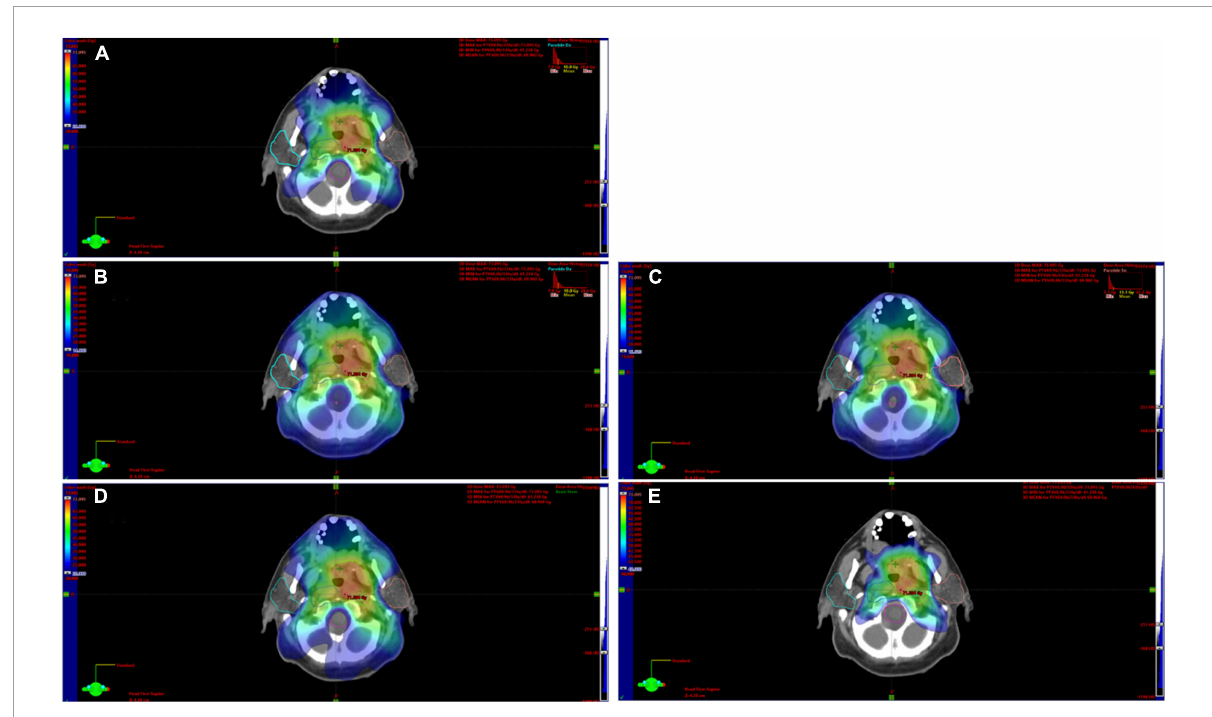
FIGURE1 Contouring of the parotids on CT images and the related dose map. In this explanatory case, both the left and right parotid showed a D20 equal to 26.8 Gy (A) . The D40 of the right parotid was equal to 14.88 (B) the left one was 15.62 (C) . Panels (D,E) show the volume covered by an isodose of 20 and 40 Gy,